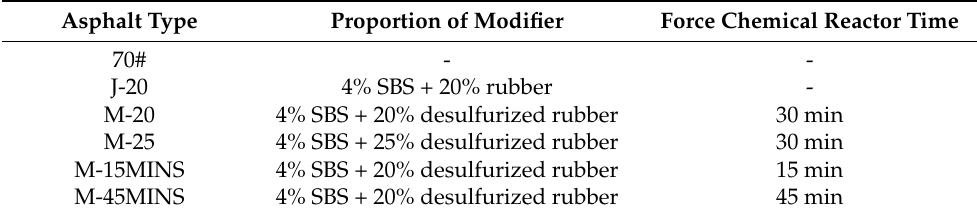
Figure 1. Flowchart of material preparation. Table 1. Types of asphalt